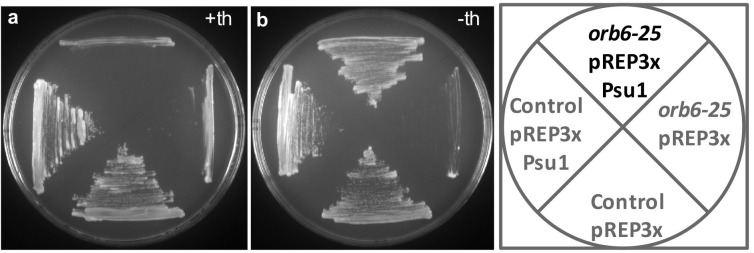
Overexpression of Psu1 suppresses the temperature-sensitive growth defect of orb6-25 mutant cells.Psu1 was expressed in orb6-25 and control cells from the pRep3X plasmid under the control of the nmt1 promoter, at restrictive temperature (36°C), in the presence (a) or absence (b) of Thiamine.